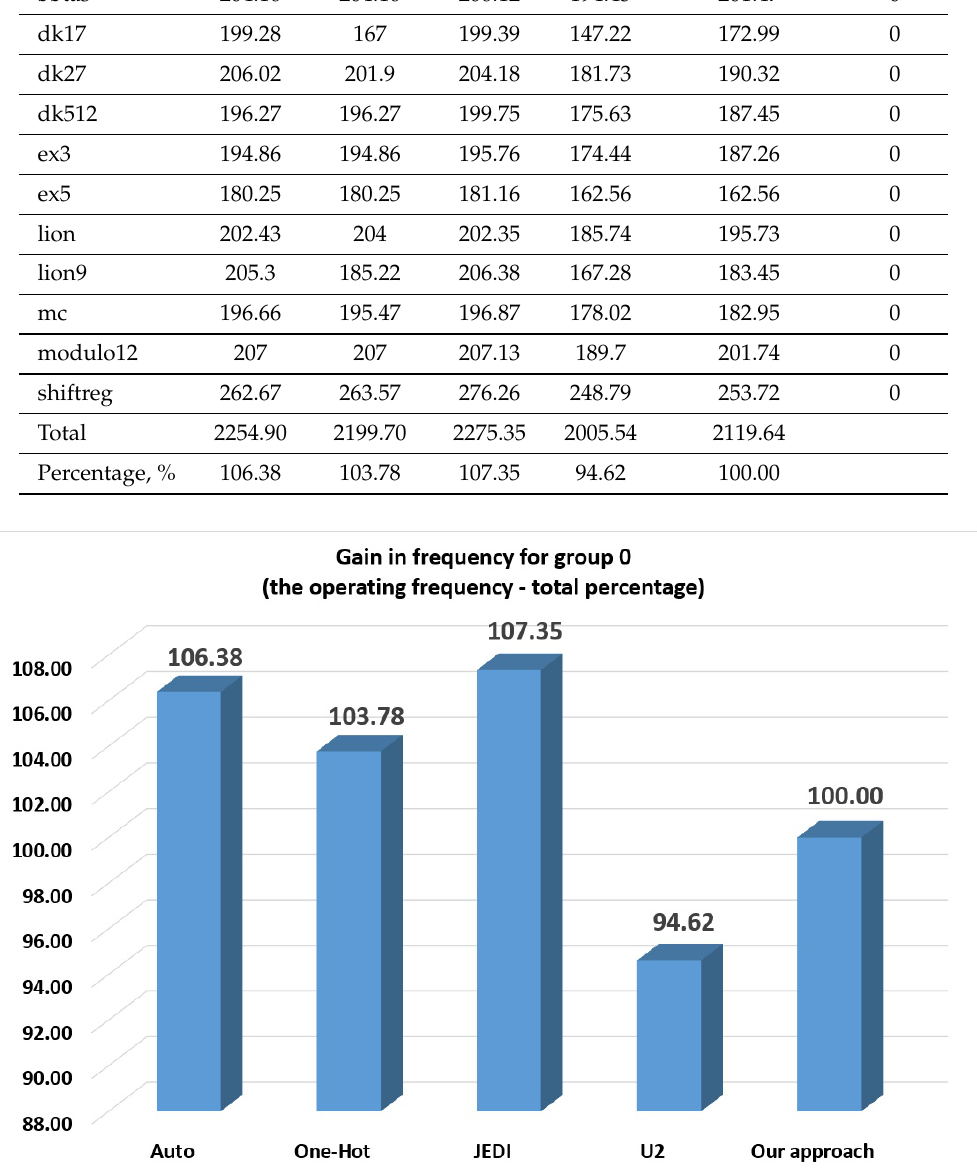
Figure 14. Gain in frequency for group 0 (the operating frequency—total